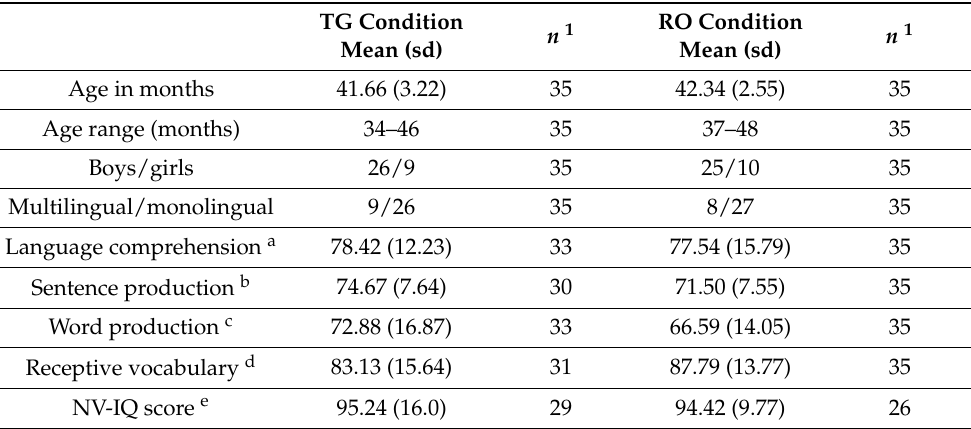
Table 1. Descriptives of the two participant groups (TG = tablet game) and RO (real objects), with means and standard deviations of age, age range, gender, language background, and scores on Dutch standardized language and non-verbal IQ tests. All standardized tests have a mean score of 100, and standard deviation − /+ 1 is 15 points.